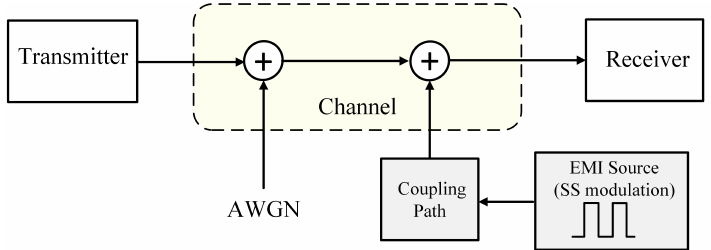
Figure 2. Block diagram representing the G3-PLC channel with the EMI